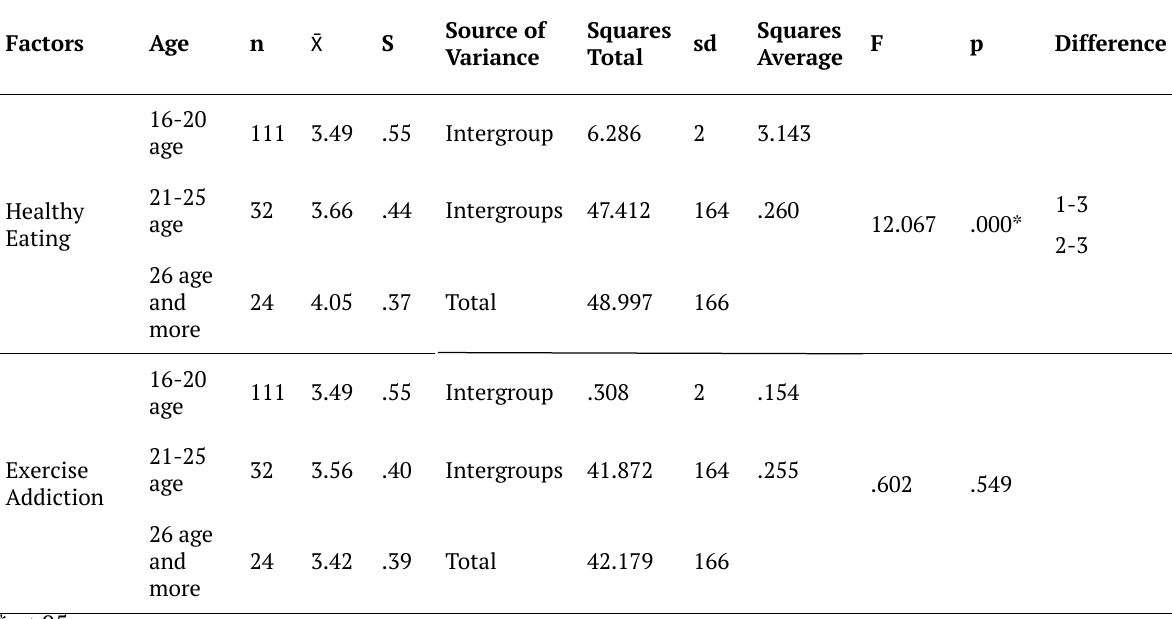
Table 4. ANOVA results of female football players’ attitude and exercise addiction to healthy eating by age Factors